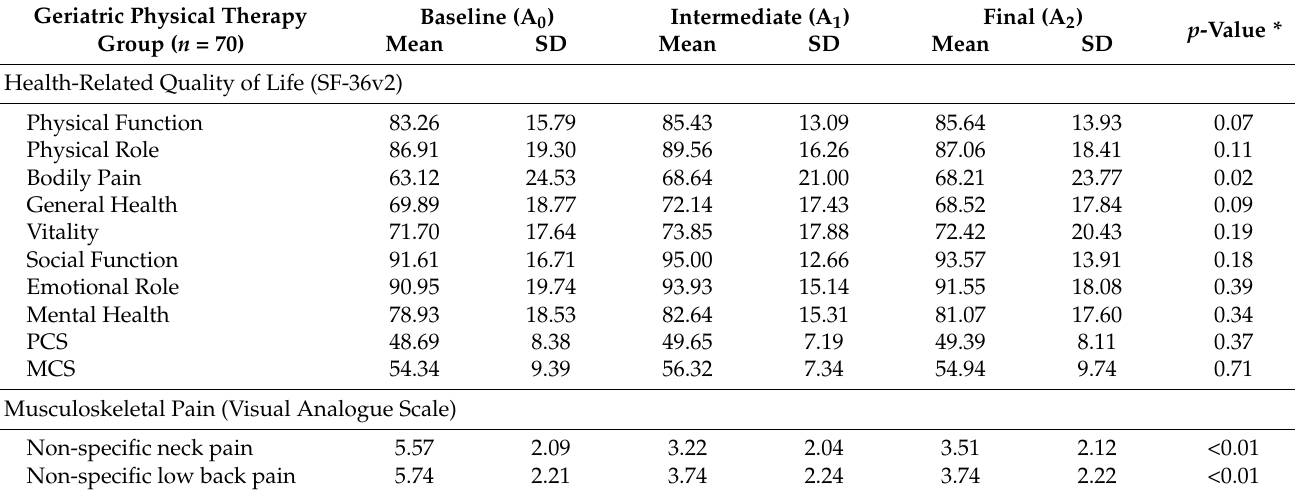
Table 4. Geriatric Physical Therapy Group at baseline (A 0 ), post-intervention (A 1 ), and final (A 2 ) assessments.